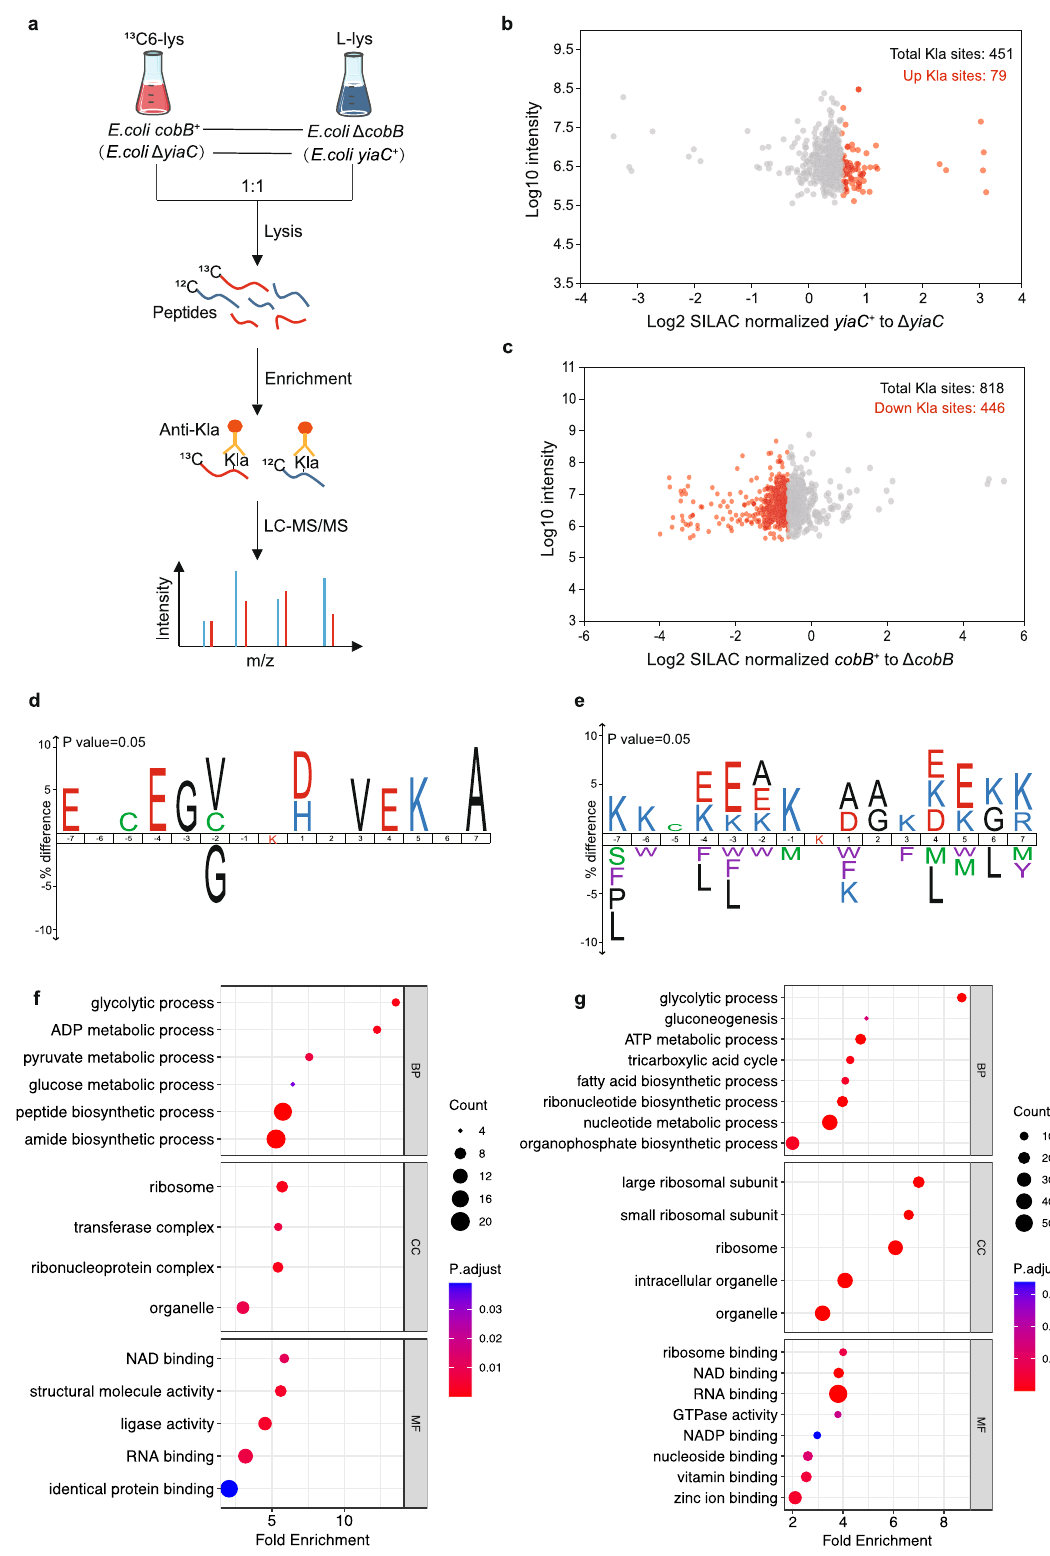
Fig. 3 | Pro fi ling endogenous substrate proteins for Kla by Yiac and CobB, respectively, in E. coli . a Schematic representation of experimental work fl ow for SILAC quanti fi cation. b Scatterplot showing the ratio of Kla peptides in E. coli MG1655 yiaC + versus Δ yiaC (normalized by protein abundance). c Scatterplot showingtheratioofKlapeptidesin E.coli MG1655 cobB + versus Δ cobB (normalized byproteinabundance). d Sequencemotiflogoshowsarepresentativesequencefor